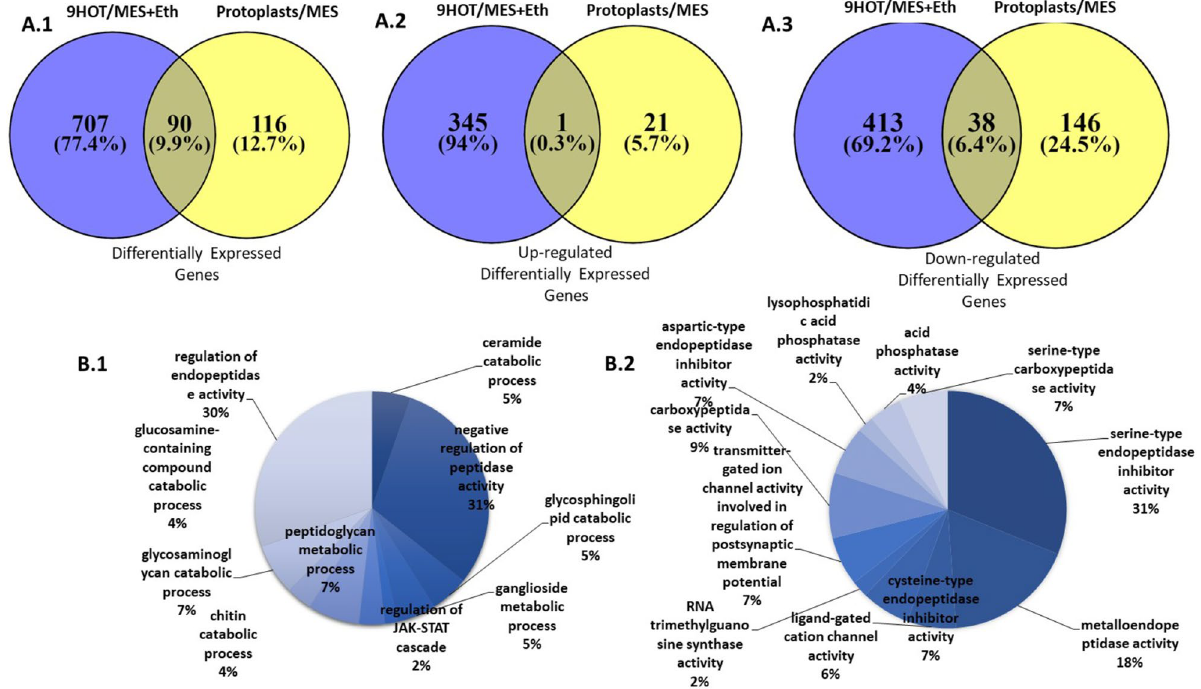
Figure 4. ( A ) Venn diagram depicting the distribution of DEG including Signal Peptide according to SignalP5.0. ( A.1 ) Venn diagram showing the number of overlapping and nonoverlapping total differentially expressed genes of M. javanica transcripts following exposure to: protoplasts/control (Cont.) and 9-HOT/ control. ( A.2 ) Distribution of up-regulated genes found in each treatment as well as genes overlapping between both treatments. ( A.3 ) Distribution of down-regulated genes found in each treatment as well as genes overlapping between both treatments. Fold change with an absolute value > 2 and < − 2 and p value ≤ 0.001 was used for the analyses. ( B ) Gene ontology (GO) annotations of differentially expressed genes including Signal Peptide according to SignalP5.0, of M. javanica J2 exposed to 9-HOT vs. control unigenes at multilevel using BLAST2go software. The GO terms were categorized into ( B.1 ) biological process and ( B.2 ) molecular function. Pie chart slices represent the percentages of unigenes identified in a particular category among the differentially expressed genes encoding